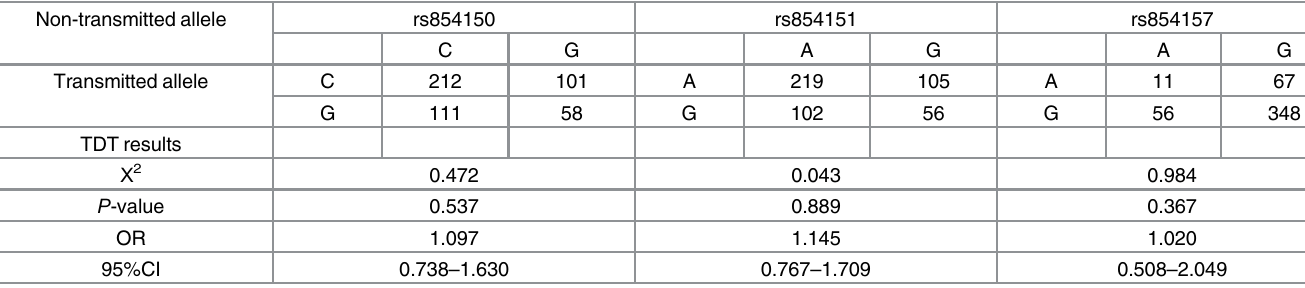
Table 1. TDT test results of three genetic loci in 241 trios.